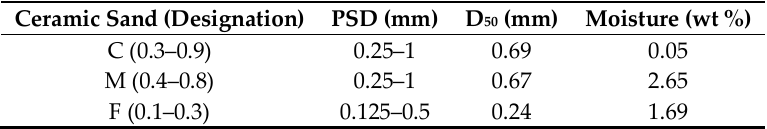
Table 2. Properties of ceramic sand examined: Particle size distribution (PSD) according to SS-EN 933-1 Standard [11], median diameter (D 50 ) and moisture